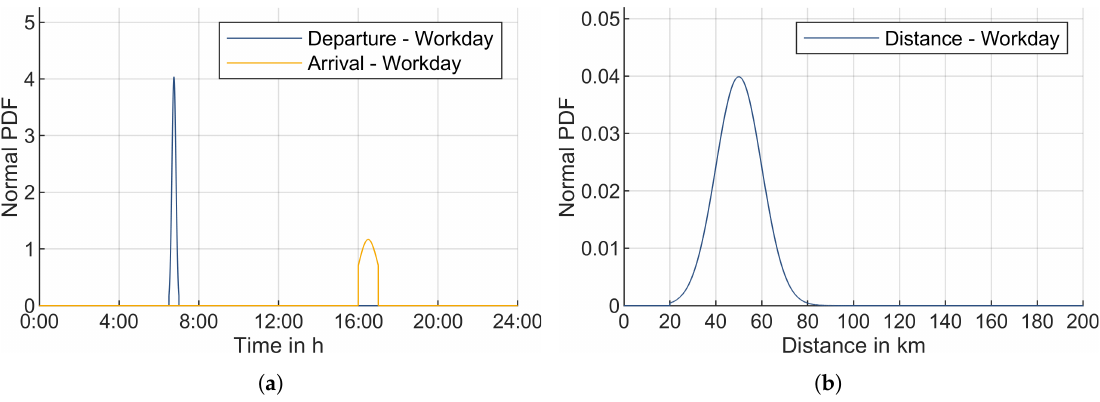
Figure 5. Probability density functions (PDFs) of the driving profiles for mobility profile Worker on a workday. ( a ) PDF of the normal distribution used to model the departure and arrival times at home on a workday (Monday–Friday) for mobility profile Worker ; ( b ) PDF of the normal distribution used to model the driving distance on a workday (Monday–Friday) for mobility profile Worker .